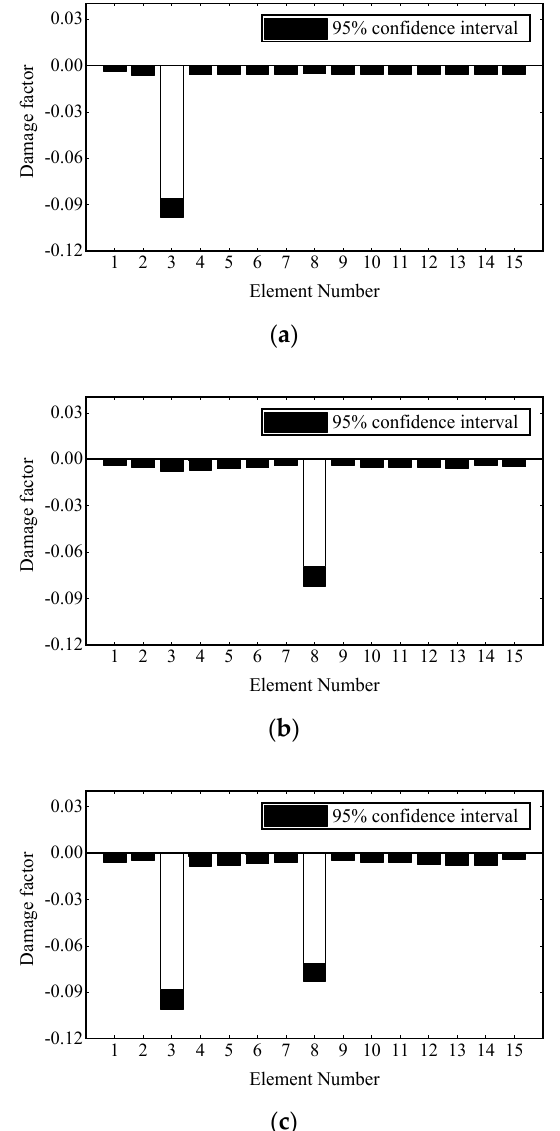
Figure 7. Damage identification results under 10% noise: ( a ) scenario 1; ( b ) scenario 2; ( c ) scenario 3.